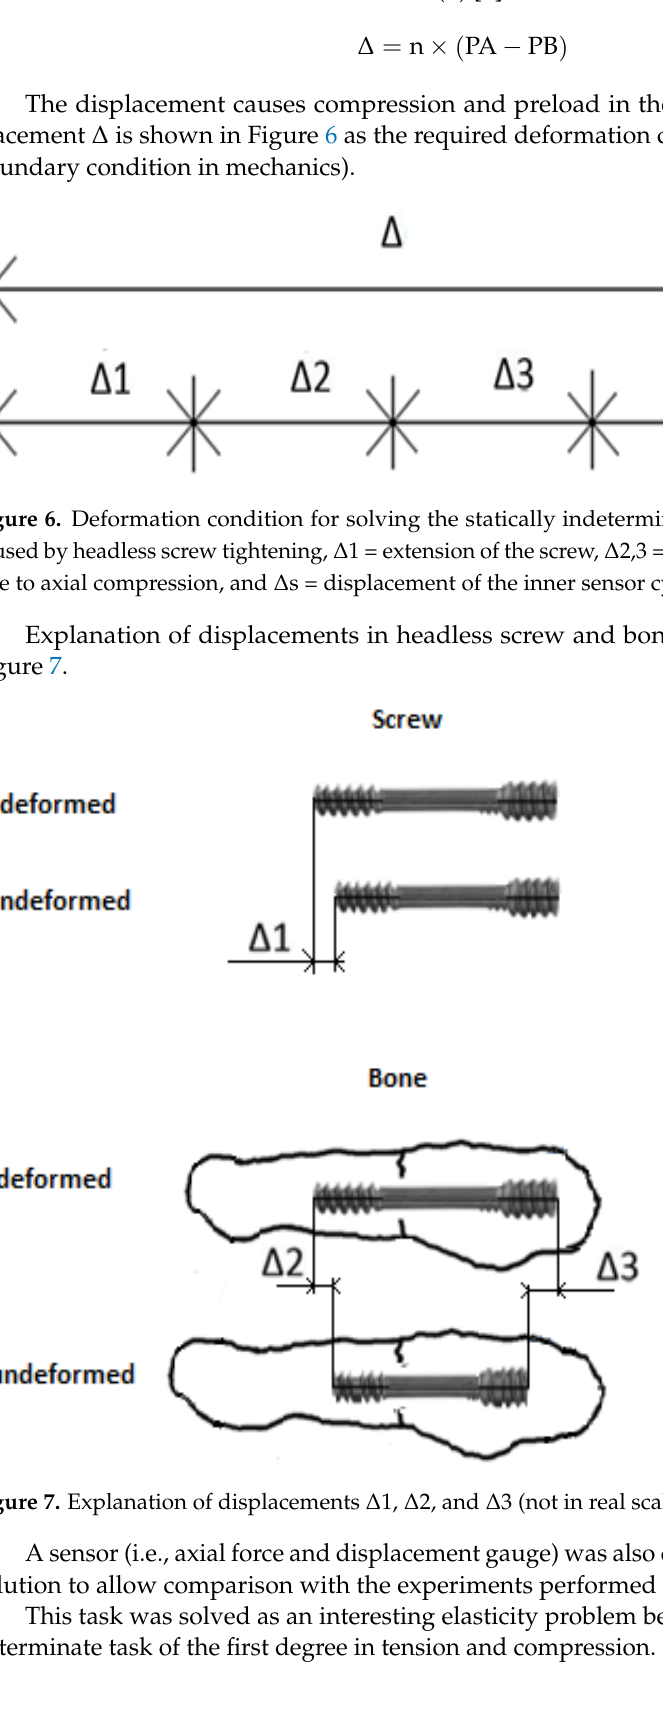
Figure 7. Explanation of displacements Δ1, Δ 2, and Δ 3 (not in real scale).